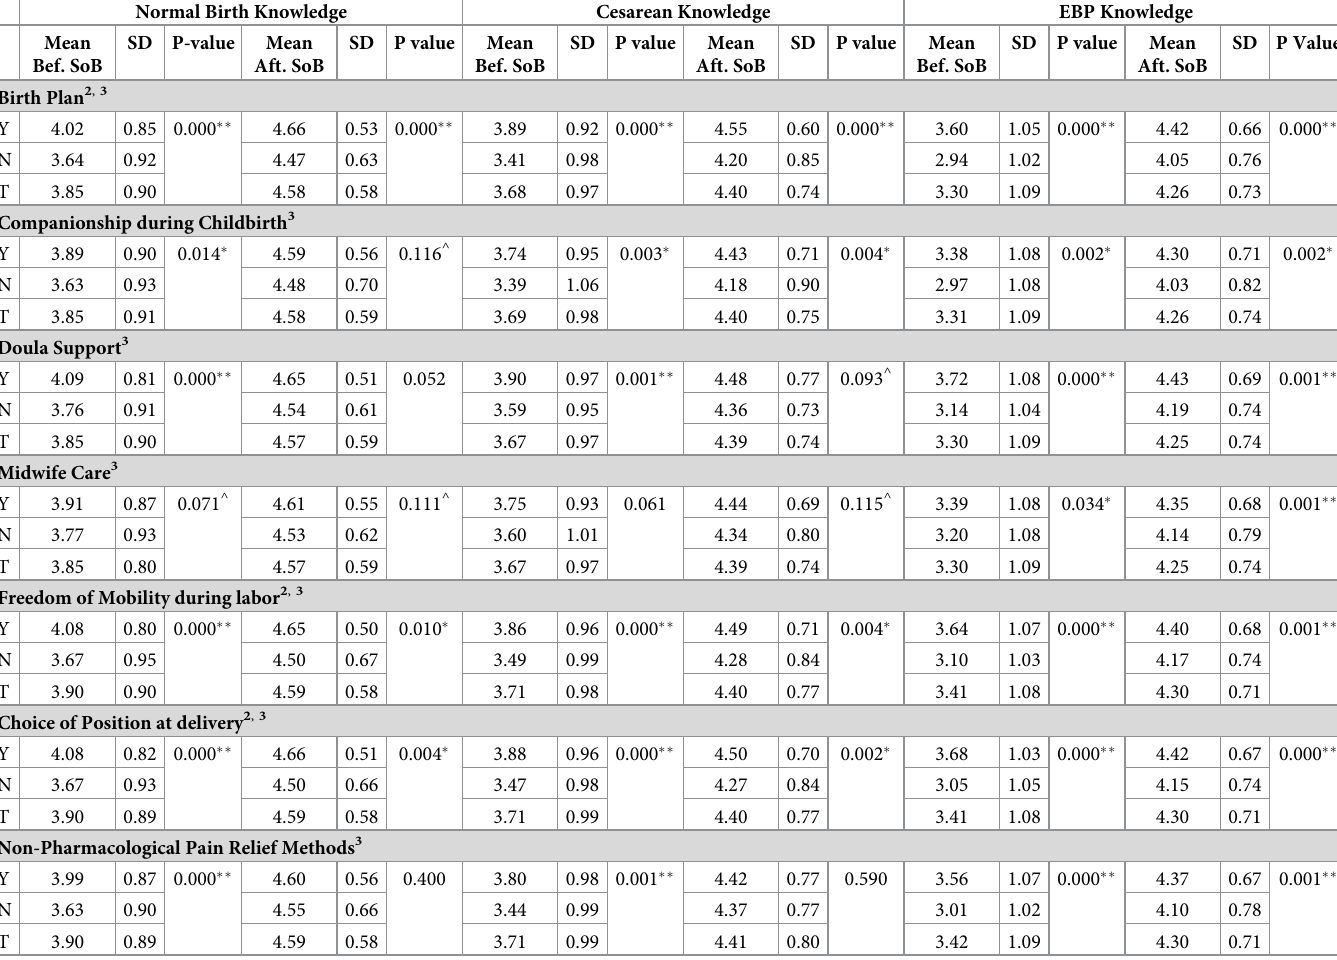
Table 5. Use of intrapartum evidence-based practices among women in the Senses of Birth intervention who participated in the follow-up survey by knowledge domain of EBP, normal birth, and cesarean mean score before and after the intervention. Brazil, 2015–2016. Normal Birth Knowledge Cesarean Knowledge EBP Knowledge Mean SD Bef. SoB